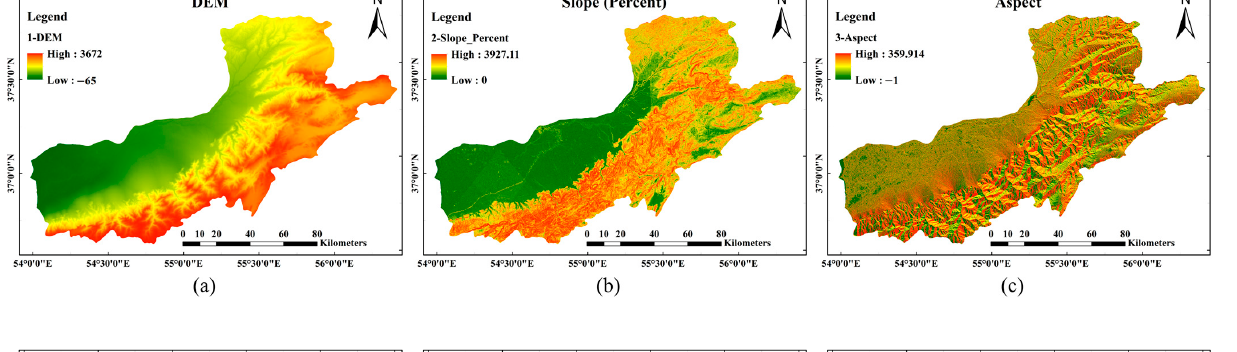
Remote Sens. 2023 , 15 , x FOR PEER REVIEW